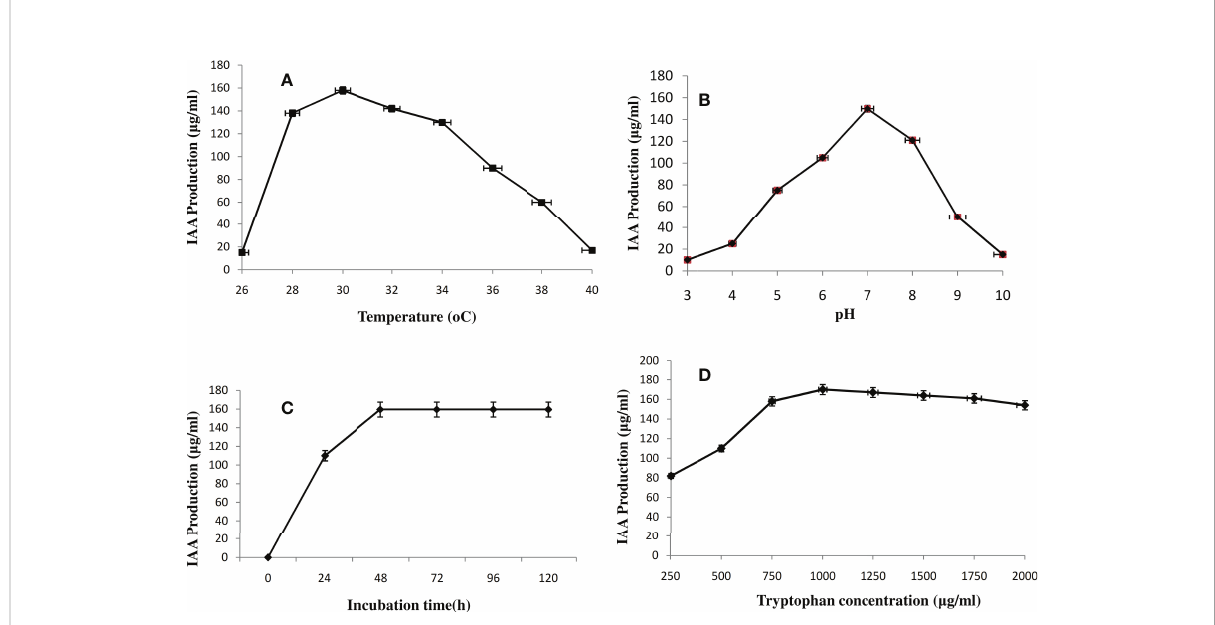
FIGURE 4 Effect of parameters (A) temperature (26-40°C), (B) pH (3-10), (C) incubation time (0-120h), and (D) Tryptophan (substrate) (250-2000 m g/mL) on IAA production by Microbacterium testaceum Y411, values are the means (n=3) ± standard deviation.